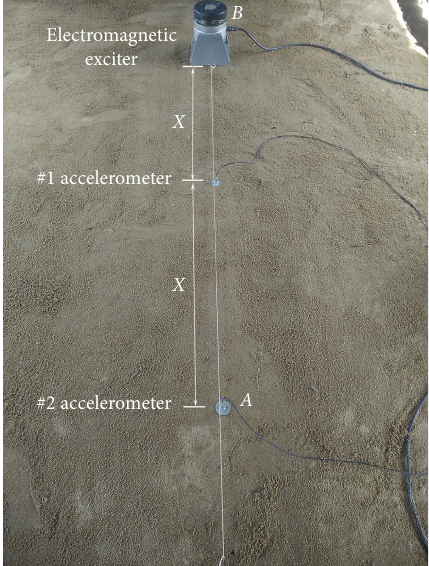
Figure 4: Layout of an accelerometer for the measurement of wave